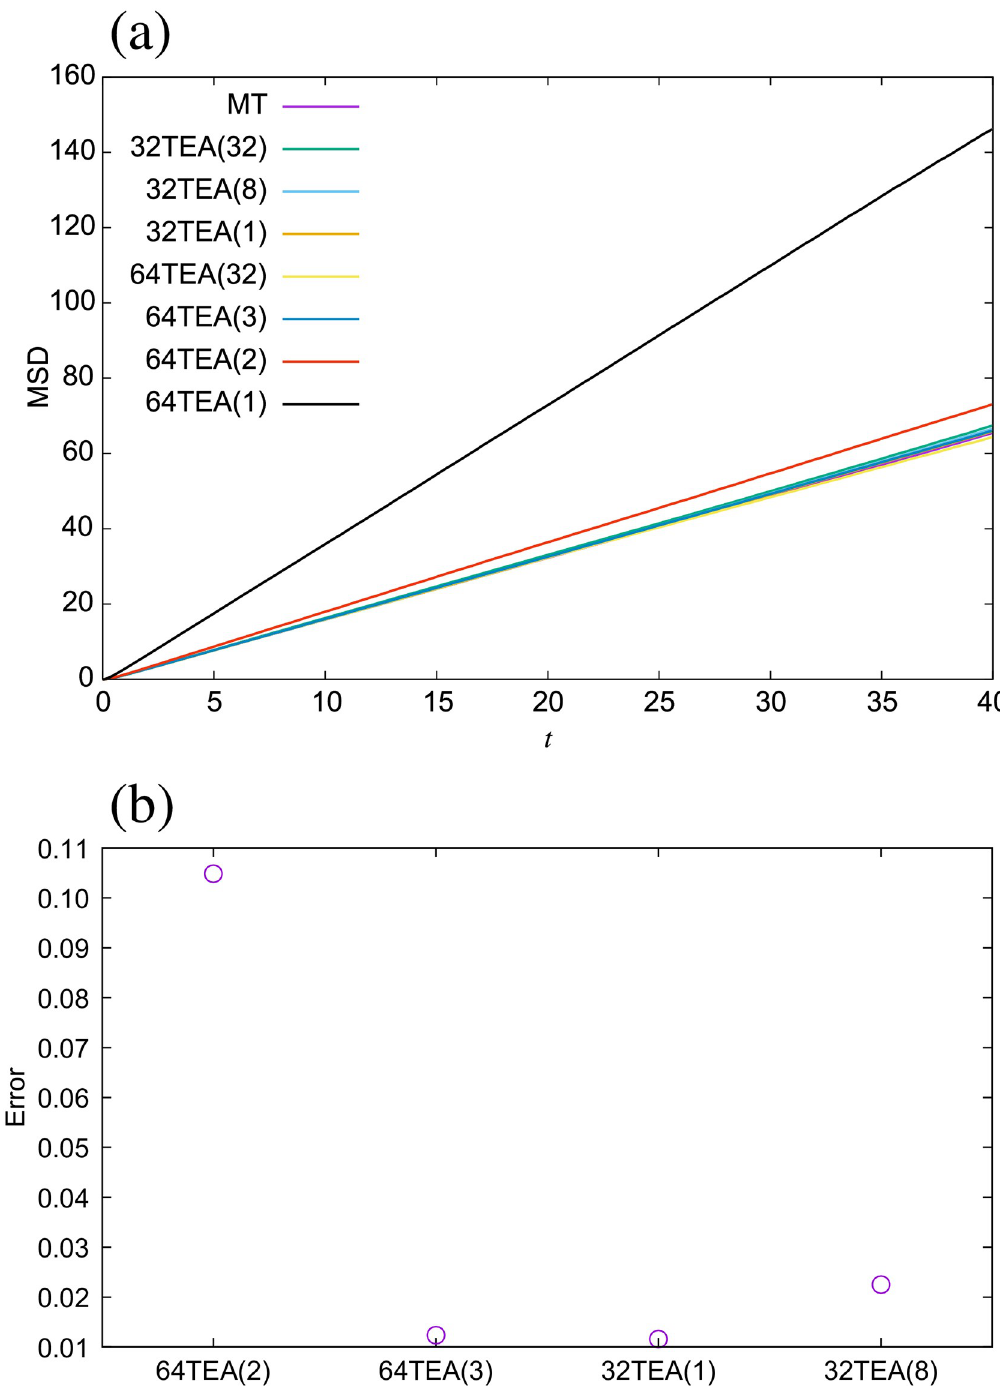
Fig 5. (a) Mean square displacement for the water system, (b) error rate of the diffusion coefficient.